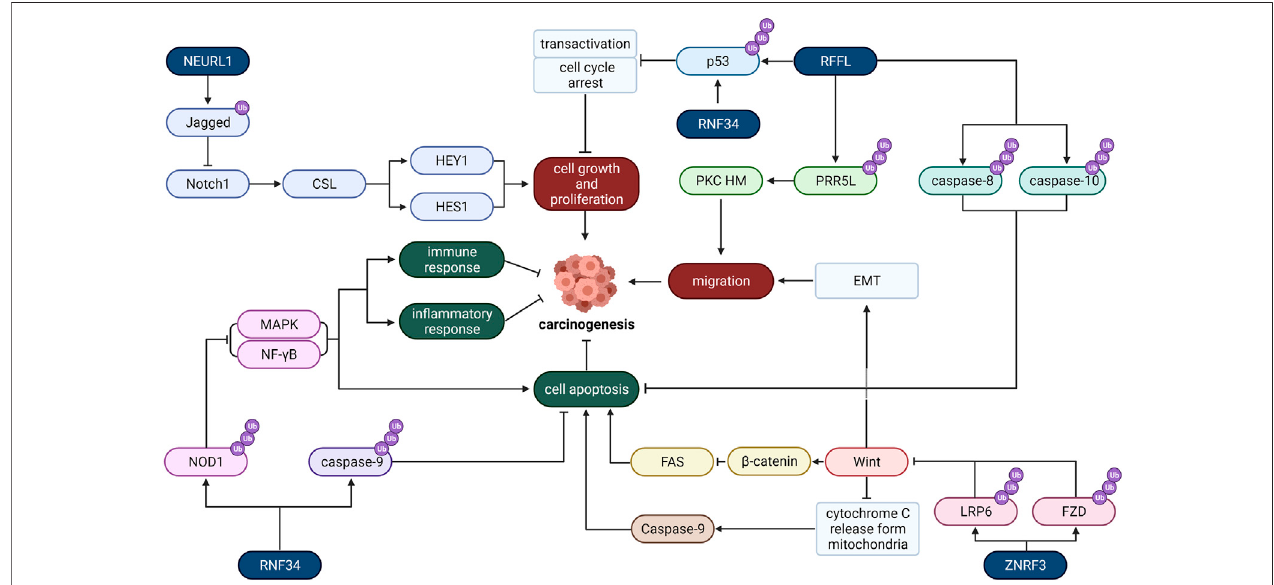
FIGURE 3 | The role of typical Plasma membrane-localized E3 ligases in cancer. RNF34, REFL, RNF34, and NEURL1 are four plasma membrane-localized E3 ligases. They regulate carcinogenesis through various pathways, including cell growth and proliferation, migration, cell metastasis, apoptosis, in fl ammatory response, and immune